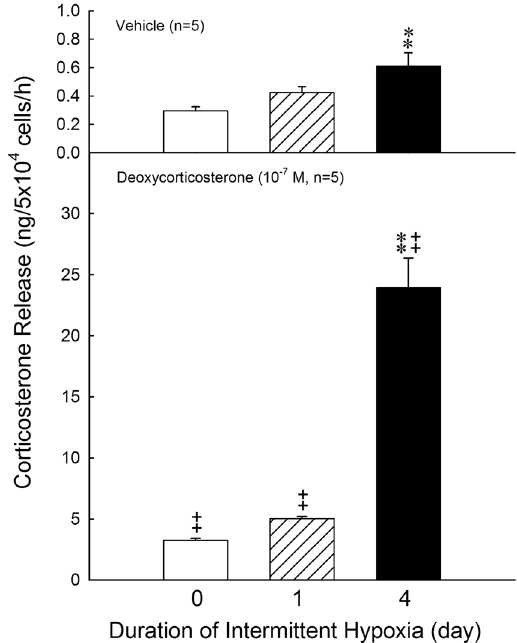
Figure 6. Effects of hypoxia on the activity of 11 β -hydroxylase in ZFR cells. ** P < 0.01 compared to normoxia (control) group. Each value represents the mean ± SEM. ++ P < 0.01 compared to deoxycorticosterone. Each value represents the mean ± SEM.